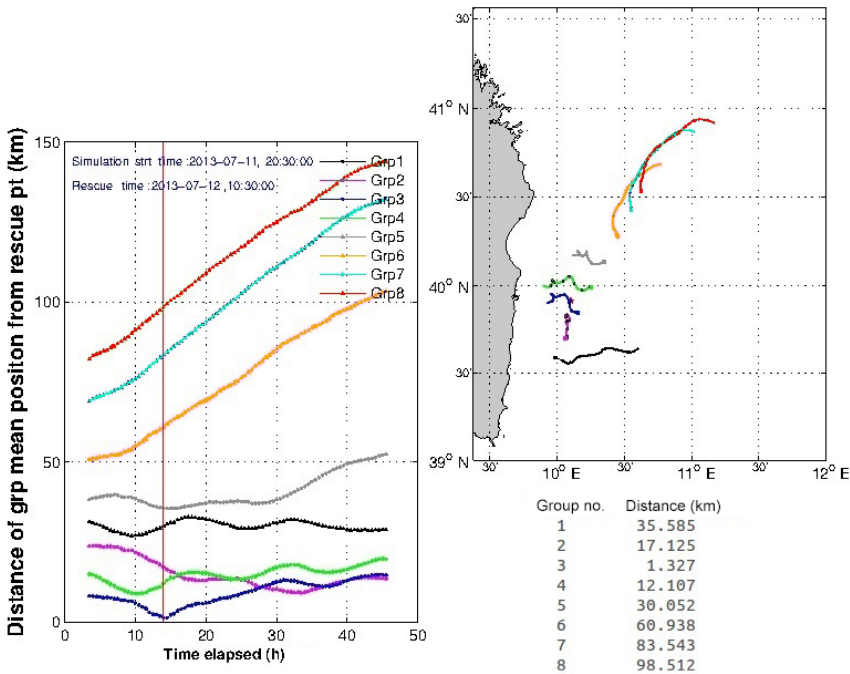
Figure 13. Distance of the mass center of each group planted every 30min from 20:30UTC (group 1) on 11 July 2013 to midnight the following day (group 8), corresponding to the solution in Fig. 12. Here the leeway is calculated by means of the force balance equation. It may be possible verify that now the solution is better than the previous ones: at the rescue time the third group (planted from 21:30 to 22:00UTC) has the smallest absolute distance and is about